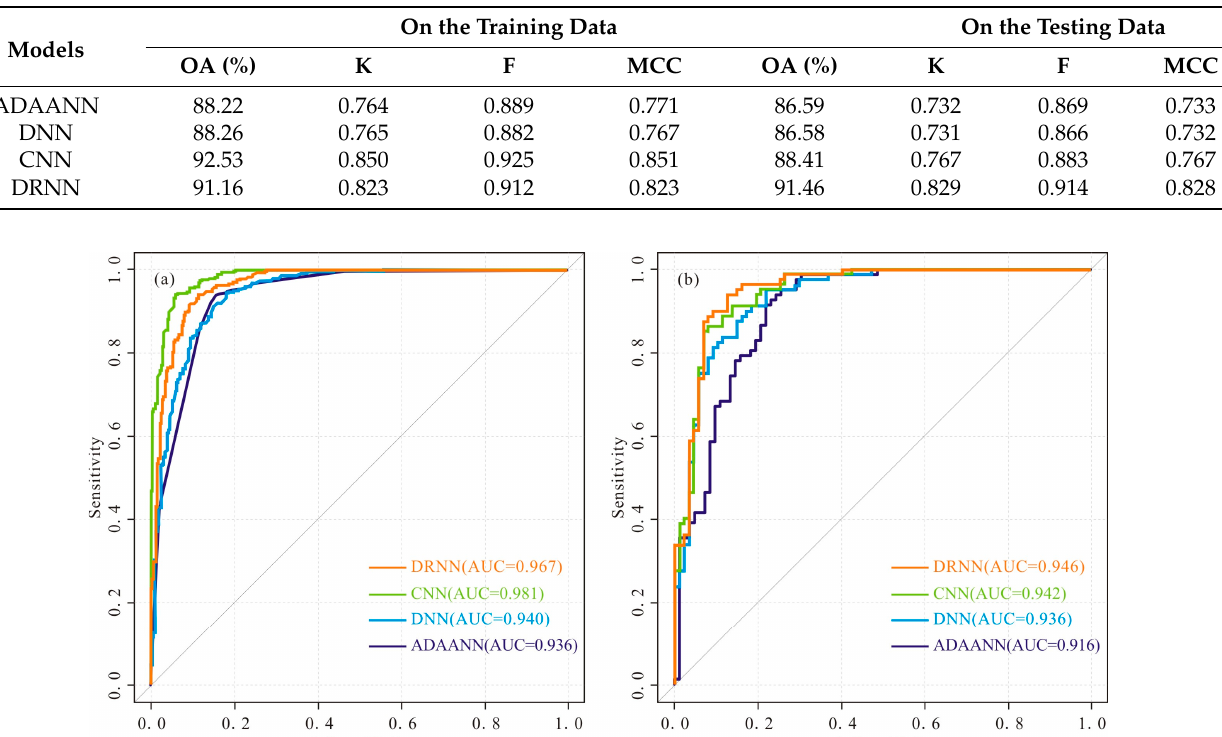
Table 3. Performance evaluation and comparison of landslide models.